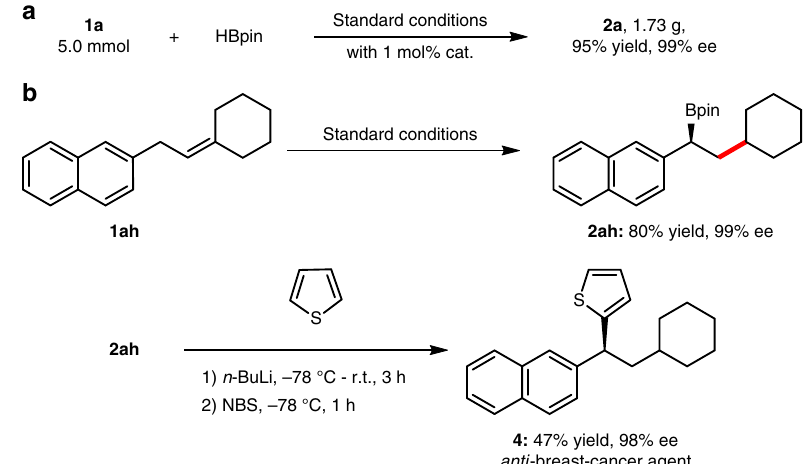
Fig. 3 Applications. a Gram-scale reaction. b Synthesis of anti -breast-cancer agent